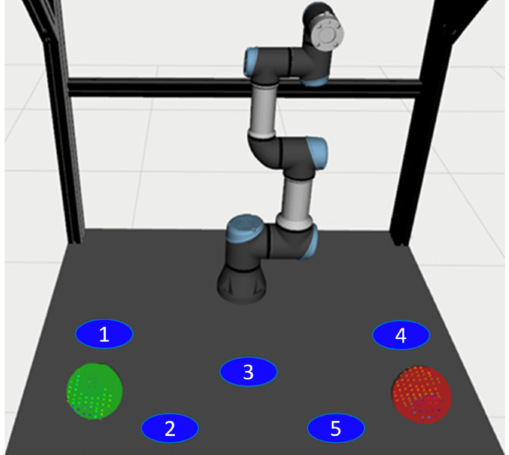
Figure 14. Preview of the workplace and the robot’s goal positions (1–5); hand positions are marked with red (right hand) and green (left hand) spheres; the robot is in the initial